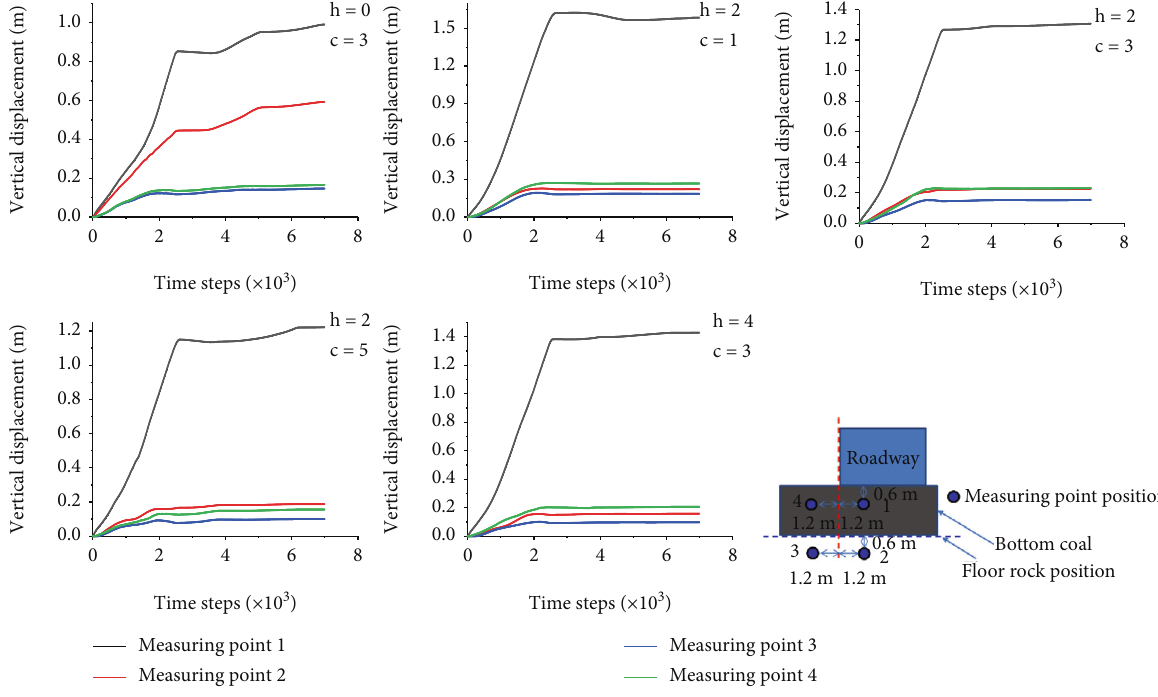
Figure 16: Curve of measuring point moving along the vertical direction in the roadway fl oor.